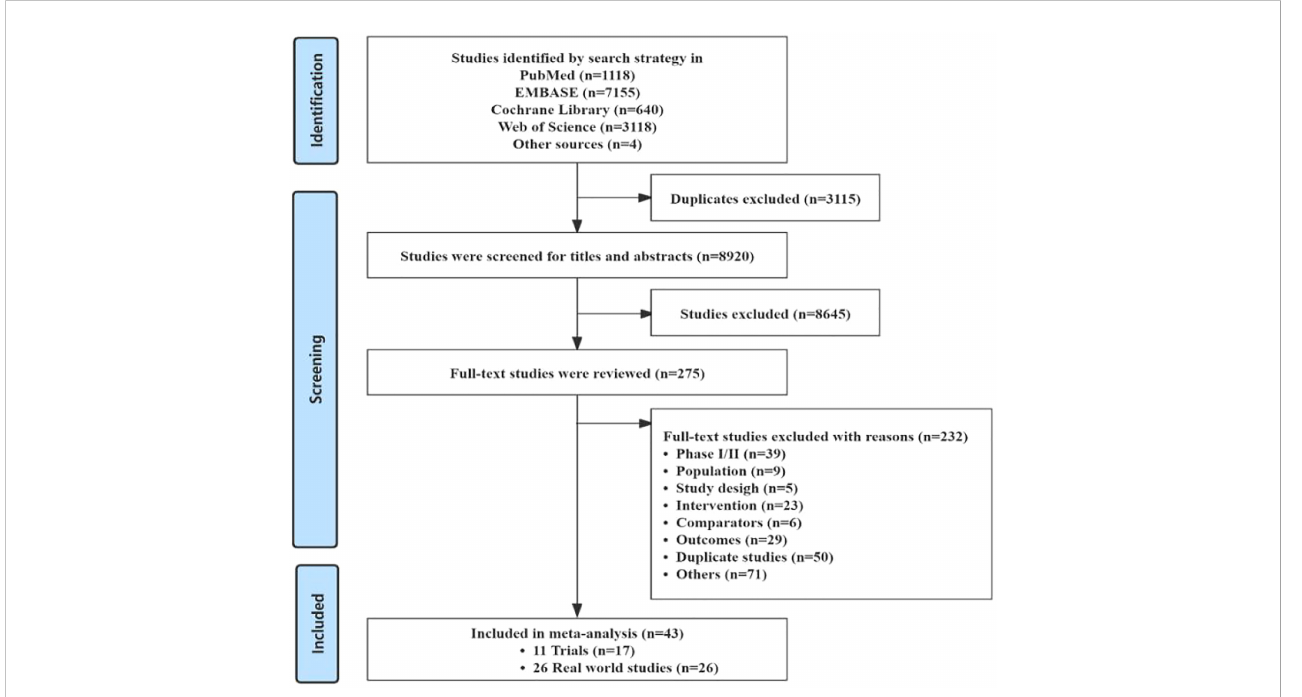
FIGURE 1 Study screening fl ow chart of literature